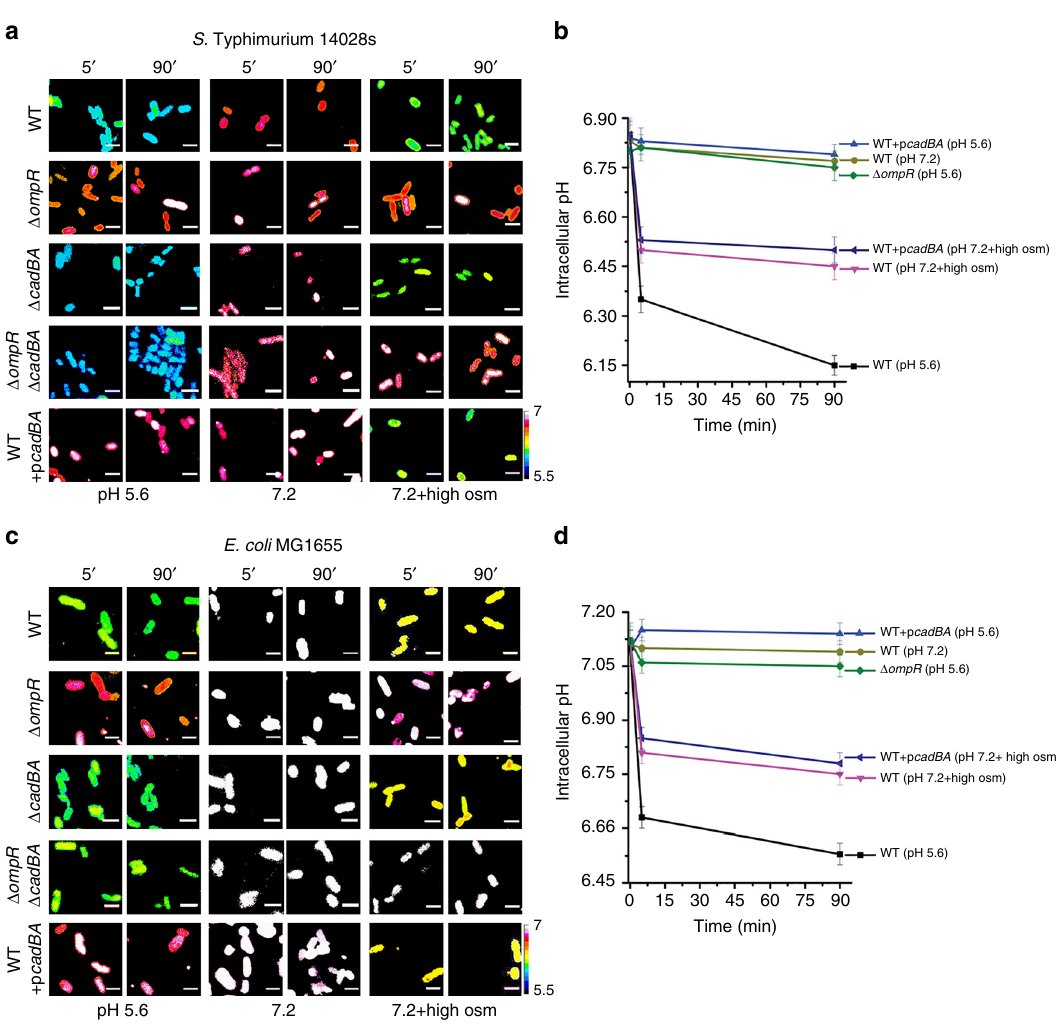
Fig. 1 OmpR drives intracellular acidi fi cation in response to acid stress. a – d S . Typhimurium and E. coli cultures were incubated with 20 µ M BCECF for 60 min before imaging. Representative epi fl uorescence ratio images (R 488/440 ) of emission channel 525 nm upon 488 nm excitation and 440 nm excitation were obtained for wild type, an ompR null mutant, an ompR /cad BA null strain, a cadBA null strain, and a cadBA over-expressed strain of a S . Typhimurium and c E. coli incubated at either acidic pH e (5.6) or neutral pH e (7.2) or at pH e (7.2) plus 15% (w/v) sucrose. Using ImageJ software, ratio images were color coded with blue (ratio = 0.1) to white (ratio = 1). Scale bar, 3 µ m. A plot of the intracellular pH of 50 cells of wild type and mutants of b S . Typhimurium and d E. coli at each indicated time point. Error bars represent the mean ± s.e.m. ( n = 3). The complete graphs including all strains in b , c are in Supplementary Fig. 2. Repression of the cad operon was not responsible for intracellular acidi fi cation during osmotic stress in S . Typhimurium and E.